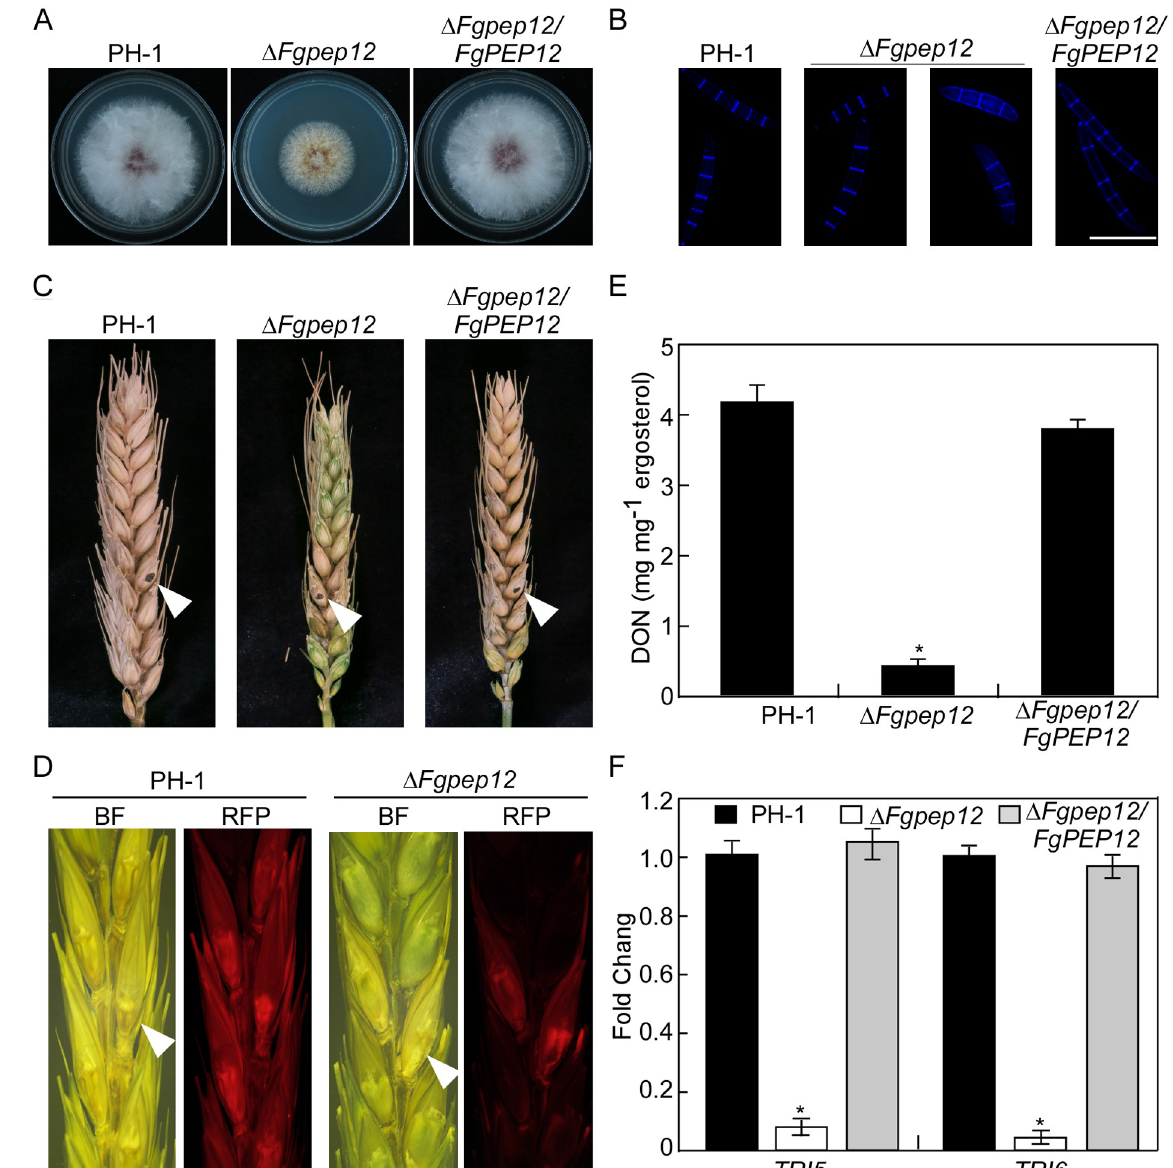
Fig 2. FgPep12 is important for vegetative growth, conidiogenesis, pathogenicity and DON production. (A) The wild type PH-1, Δ Fgpep12 mutant and the complemented transformant Δ Fgpep12/FgPEP12 were cultured on CM- media at 25˚C for 3 days in the dark, and photographed. (B) Conidia of the indicated strains were harvested from CMC medium, and stained with calcofluor white, and observed under a fluorescence microscope. Bar = 10 μ m. (C) Infection assays on flowering wheat heads. Conidia suspensions (10 μ l) of PH-1, Δ Fgpep12 and Δ Fgpep12/FgPEP12 were injected into the flowering wheat heads. Photographs were taken at 14 days post-inoculation (dpi). Inoculated site were pointed by white arrows. (D) Spikelets were inoculated with conidia from PH-1 and Δ Fgpep12 strain expressing FgACTIN - RFP construct. Images were taken at 7 dpi. Inoculated spikelets were indicated by white arrows. (E) DON production in wheat kernels infested by the indicated strains for 20 days. (F) Relative transcription abundance of trichothecene synthase genes TRI5 and TRI6 in the indicated strains. Error bars represent the SD and asterisks indicate statistically significant differences ( p <